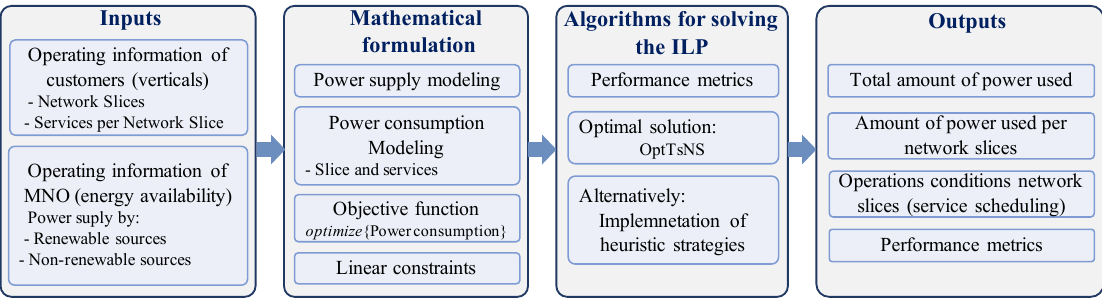
Figure 5. Schematic of the adaptive energy management model for 5G Network